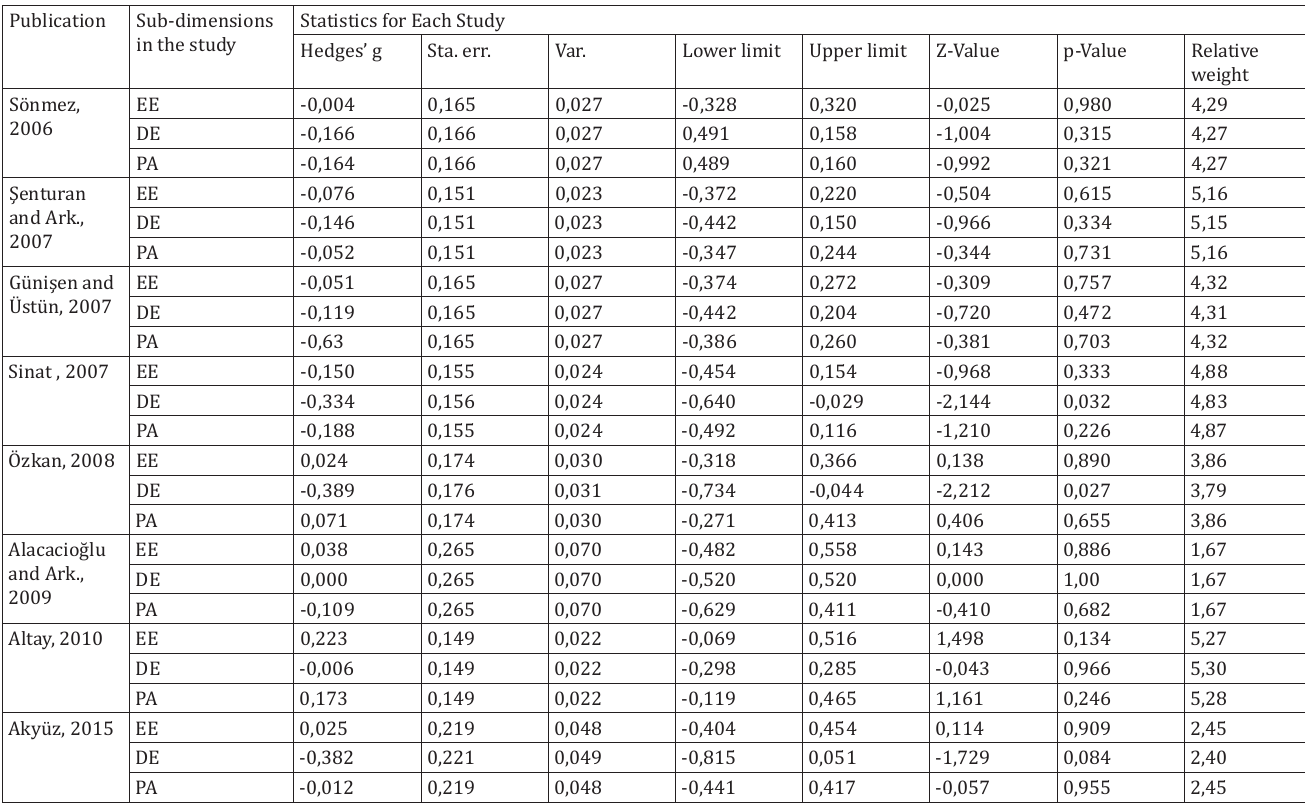
Confidence intervals and ranges of the effect sizes of the studies included in the